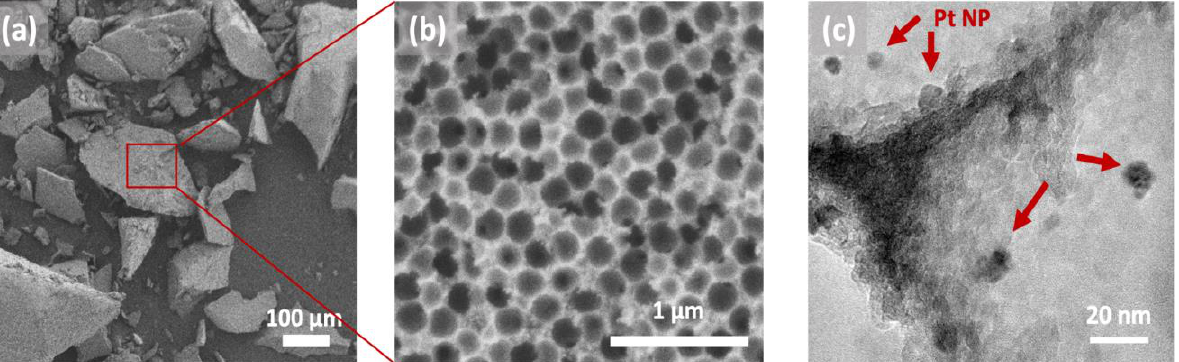
Figure 7. Representative scanning and transmission electron microscopy (SEM and TEM) images of Pt/Al 2 O 3 powders synthesized using a conventional method (Shards) and building blocks shown in Figure 2. ( a , b ) SEM images of Pt/Al 2 O 3 powder particles with the interconnected porous network visible in the high magnification image ( b ); ( c ) high resolution TEM image of Pt NPs (dark dots) supported on alumina.